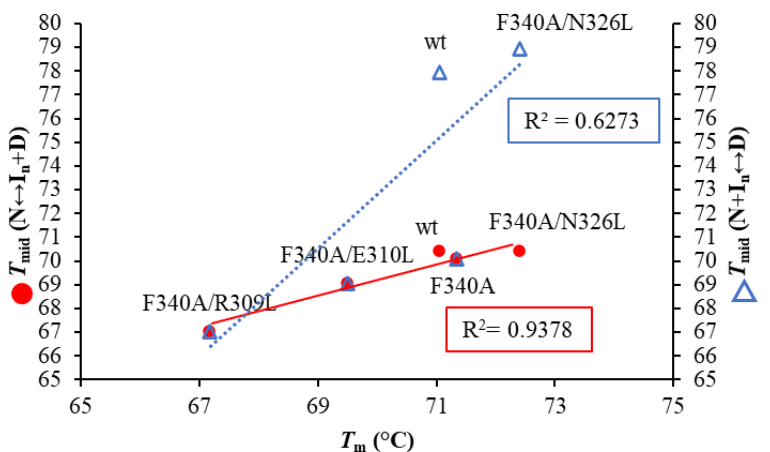
Figure 5. Correlation plots between T m calculated by CD denaturation curve and T mid (N ↔ I n + D), T mid (N + I n ↔ D) calculated from the molar fractions as determined by DSC analysis. The CD denaturation curve and DSC measurement were measured at 0.5 mg/mL and pH 7.5 at a scan rate of +1.0 °C/min. The red circles (●) represent T mid (N ↔ I n +D) and the blue open triangles (∆) present T mid (N + I n ↔ D).